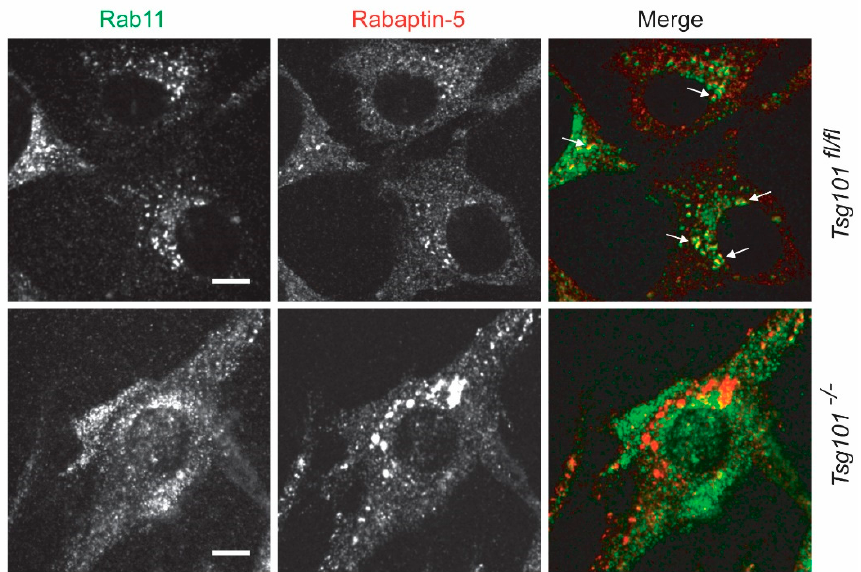
Figure 2. The knockout of TSG101 causes a dissociation of a subset of early endosomes from recycling endosomes Confocal microscopic images of TSG101 conditional knockout fibroblasts 48 h after infection with a pBabe-Cre virus ( Tsg101 -/- ) and their isogenic control cells expressing endogenous TSG101 ( Tsg101 fl/fl ), which were infected with the pBabe control vector. Cells were stained with antibodies against Rab11 (green) and Rabaptin-5 (red); bar represents 10 µm. Arrows indicate examples for a colocalization of both markers (yellow) in wildtype controls.